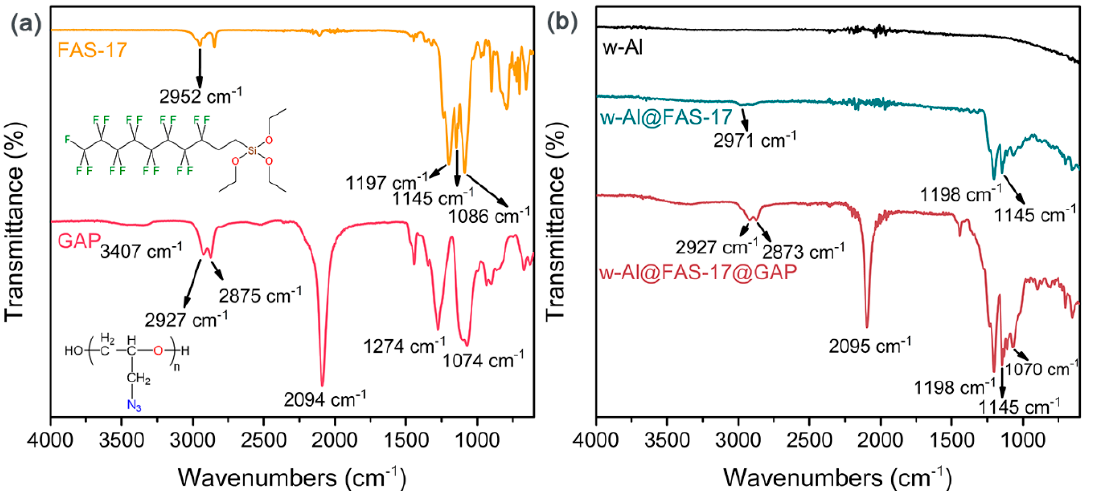
Figure 3. FTIR spectra of FAS-17, GAP ( a ) and w-Al, w-Al@FAS-17, w-Al@FAS-17@GAP ( b ). (2971– 2952 cm − 1 , CH 3 ; 1197 cm − 1 , C-F; 1145 cm − 1 , Si-O; 1086–1070 cm − 1 , C-O; 3407 cm − 1 , OH − ; 2927 cm − 1 , CH 2 ; 2875 cm − 1 , CH; 2094 cm − 1 , -N 3 ; 1274 cm − 1 − 1 ,